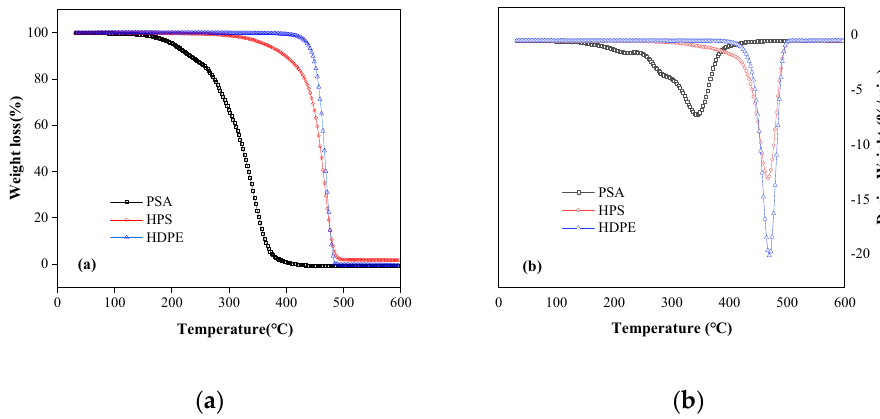
Figure 5. Thermal analysis of different materials: ( a ) thermogravimetry (TG) and ( b ) derivative thermogravimetry (DTG).